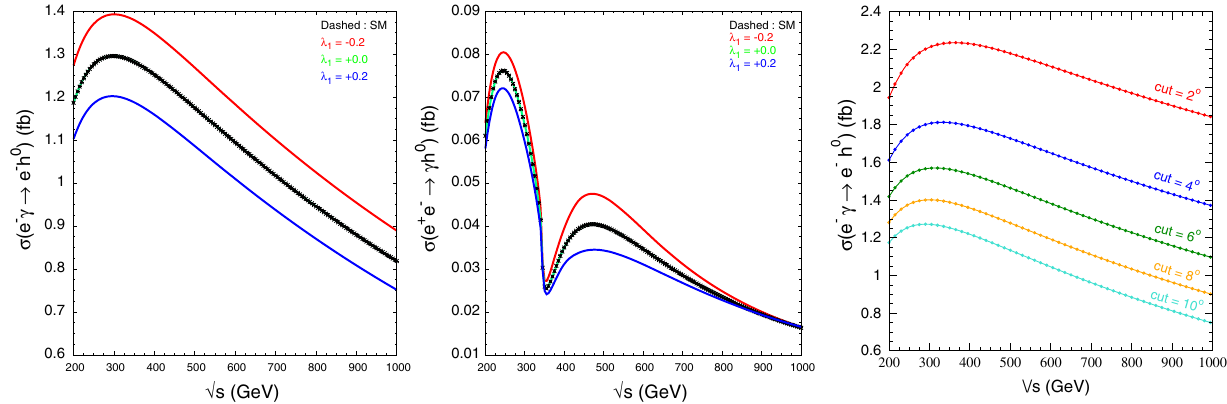
= 0. In the right side the total cross section v Δ = μ = 1 GeV and λ √ 4 σ( e − γ → e − h 0 ) in fb is displayed as a function of s for five different